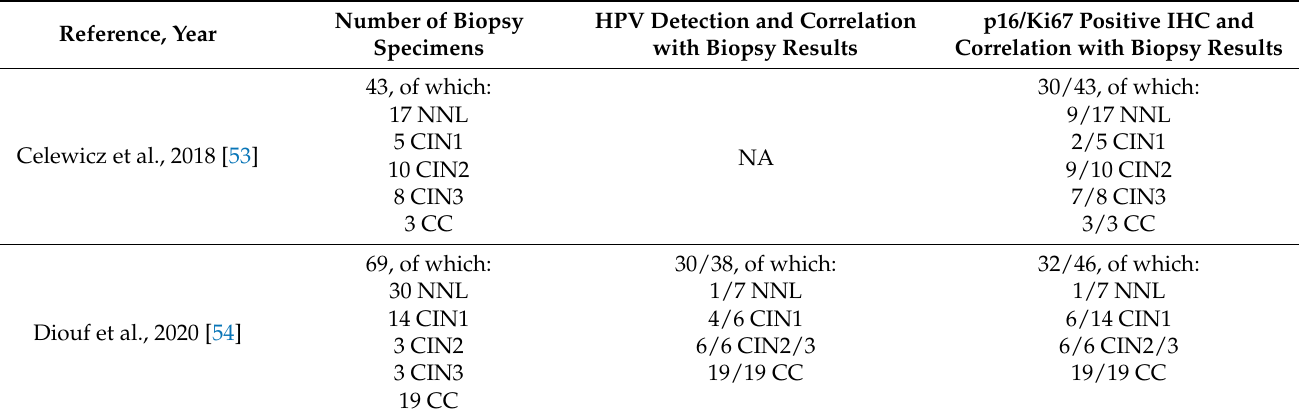
Table 2. p16/Ki-67 DS in cervical tissue biopsy